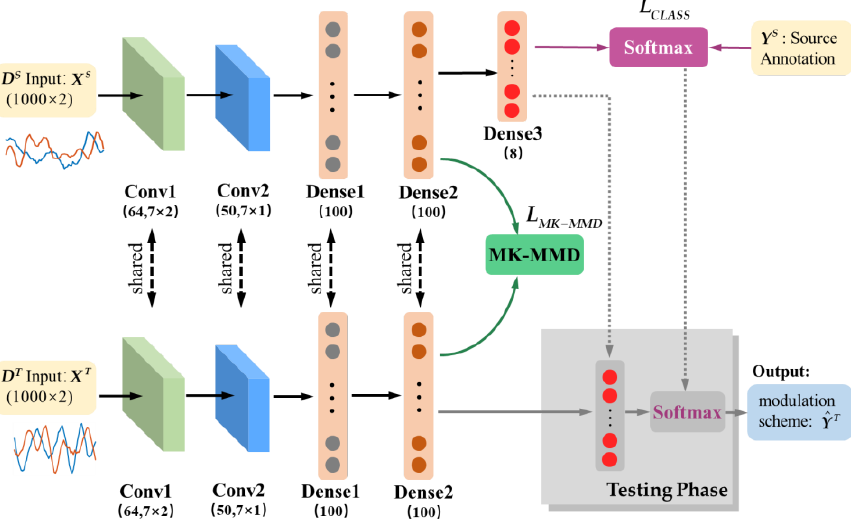
Figure 2. Illustration of the proposed CNN-MK-MMD architecture.